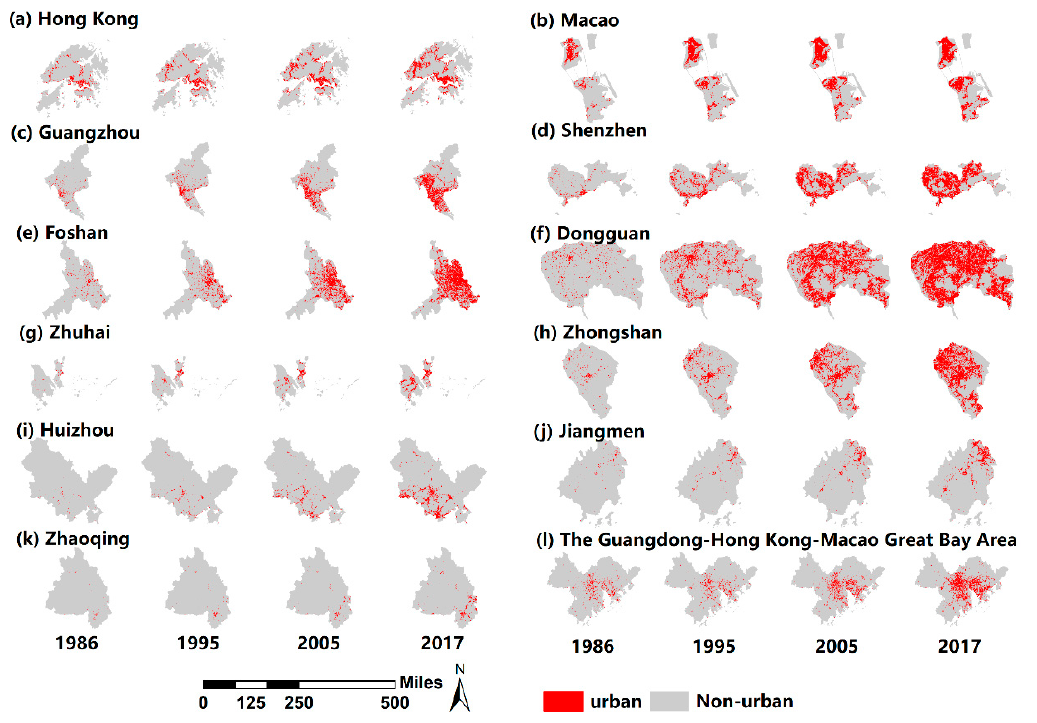
Figure 3. The urban areas of every city in the GBA from 1986 to 2017.